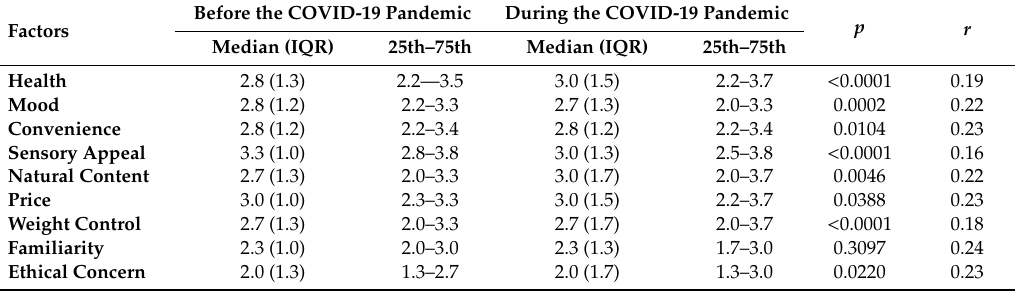
Table 6. The factors influencing food choice based on the applied Food Choice Questionnaire (FCQ) for the period before and during the COVID-19 pandemic for the sample of female adolescents studied within the PLACE-19 Study ( n =